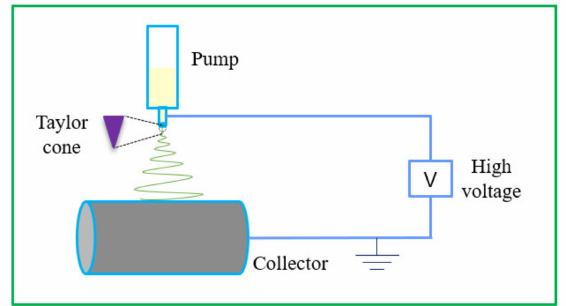
Figure 1. Schematic diagram of a typical electrospinning